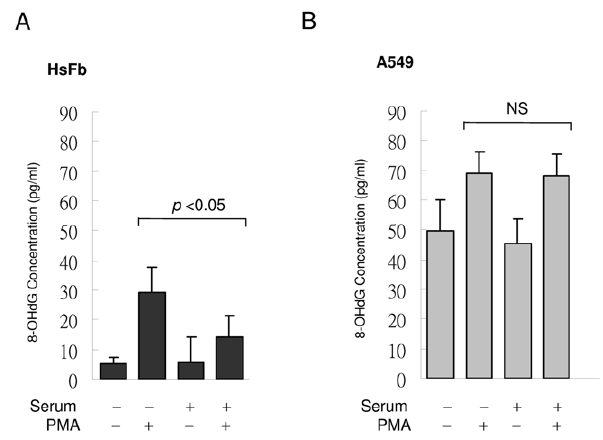
Figure 11. 8-OHdG levels in SF- vs. SR-HsFb and A549 cells. ( A ) SF- or SR-HsFb were treated with PMA for 4 h and 8-OHdG was measured. ( B ) SF- and SR-A549 cells were treated similarly to ( A ). Each bar denotes mean 6 SEM (n=3). NS denote statistically